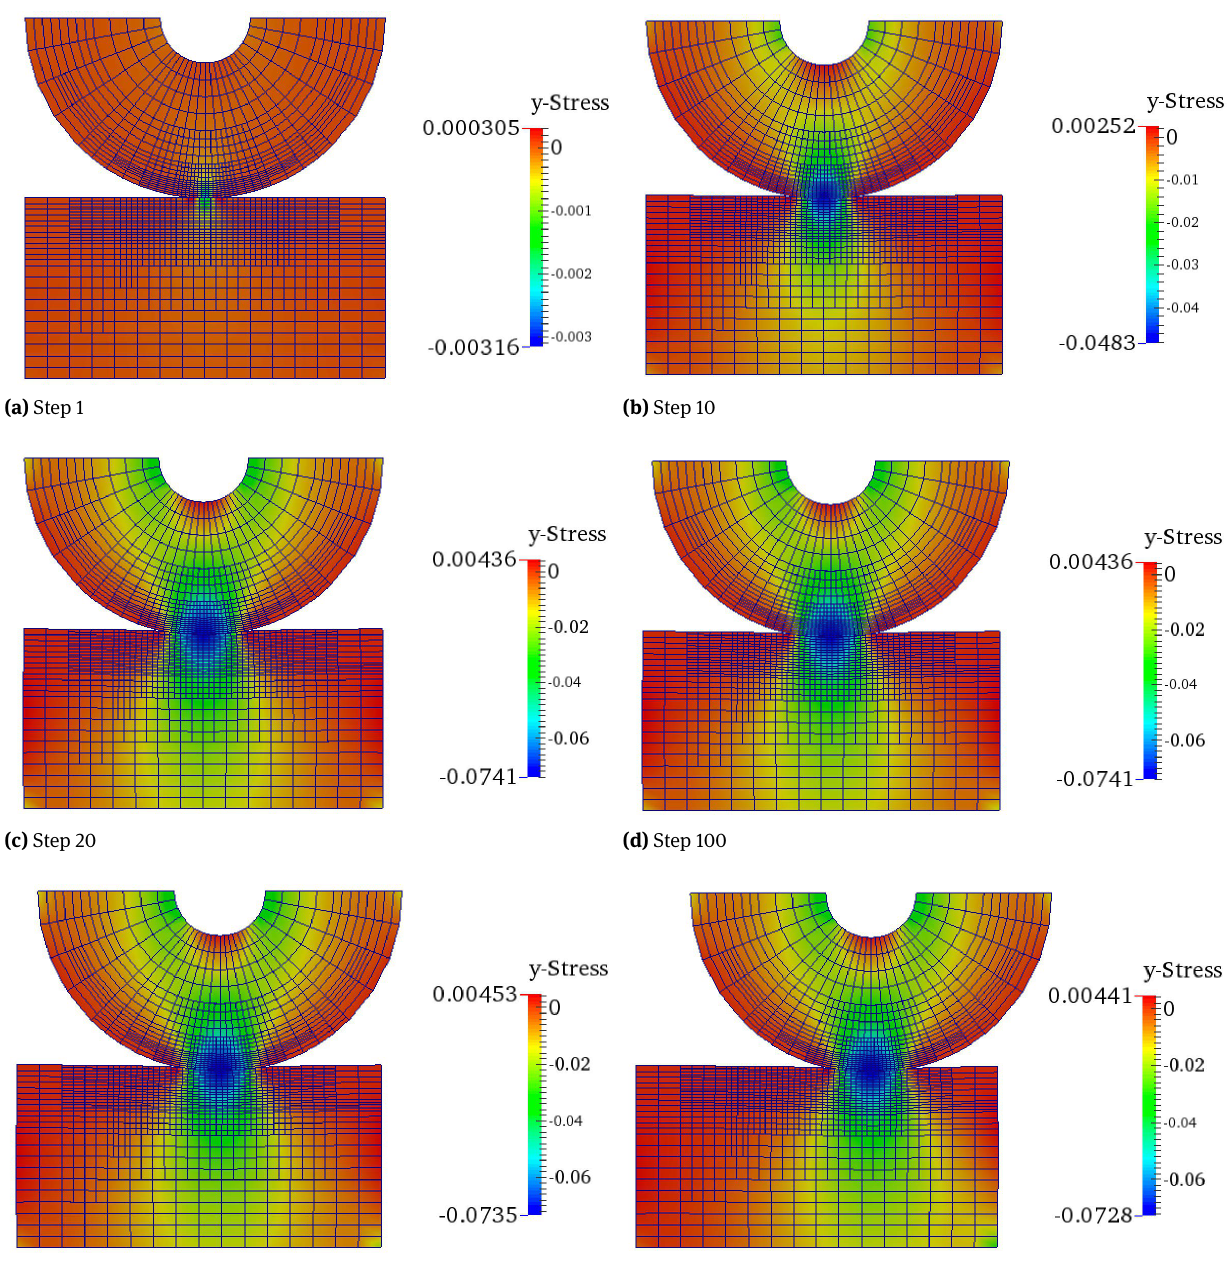
Figure 14: Ironing problem: deformed shape for T-mesh 1. Dof = 1044